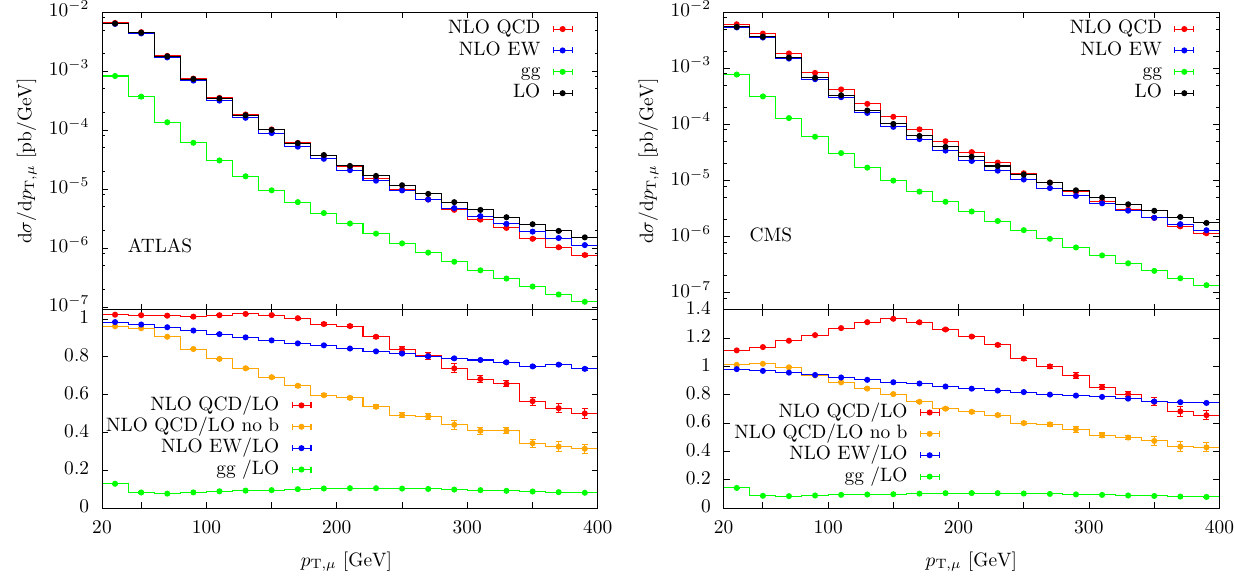
√ s = 13TeV for the ATLAS